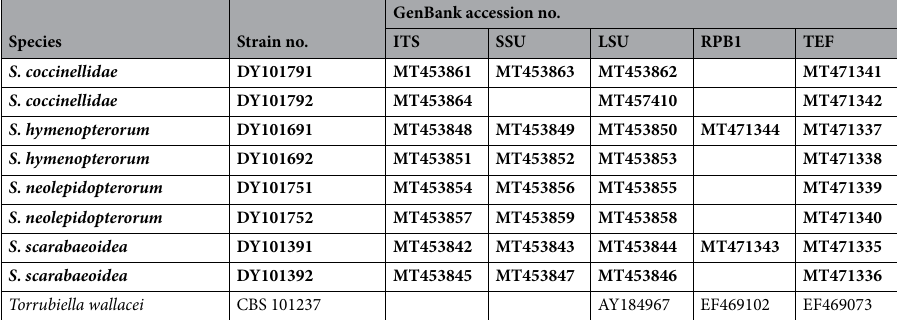
Table 2. Taxa included in the phylogenetic analyses. Sequences generated in this study are shown in